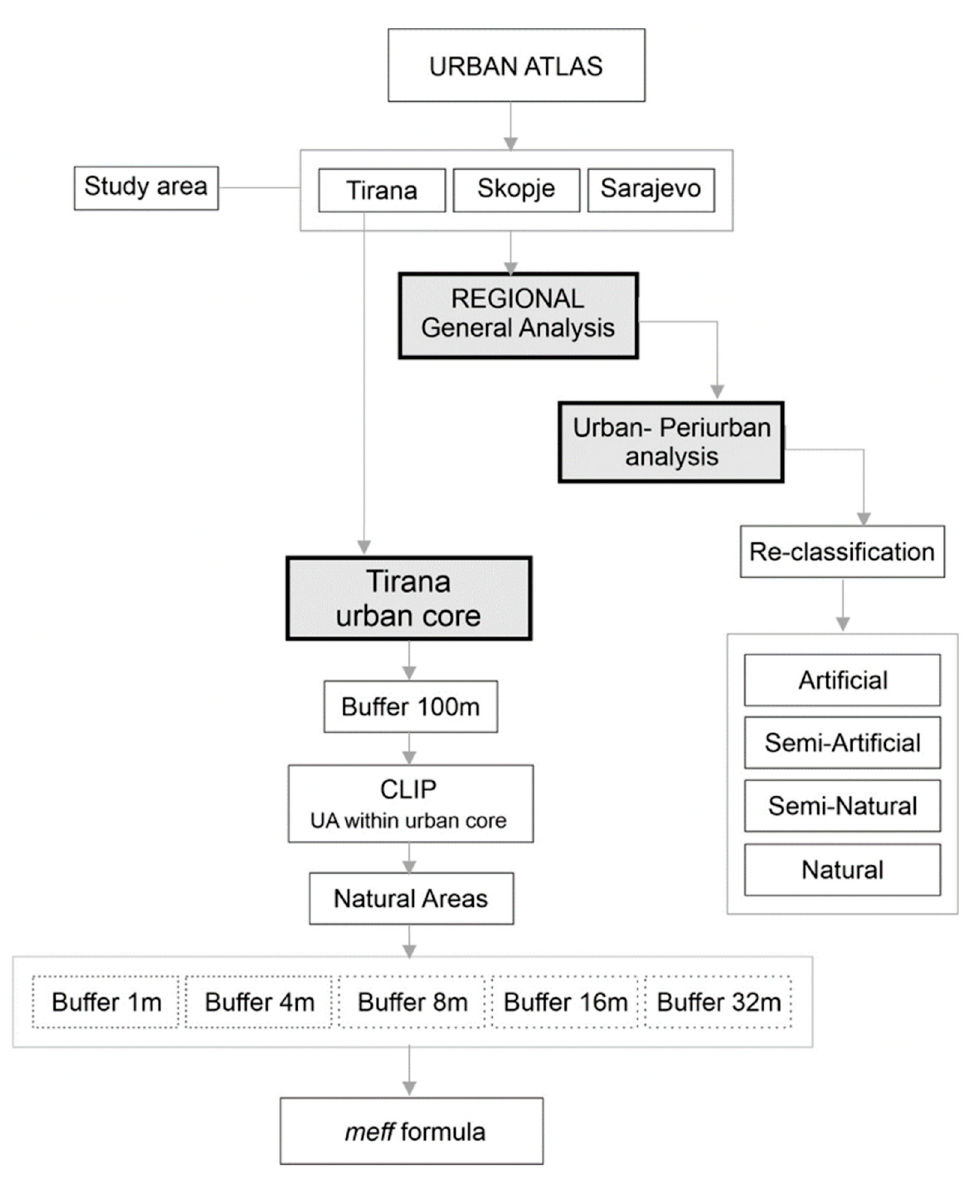
Figure 2. The workflow of the method applied.